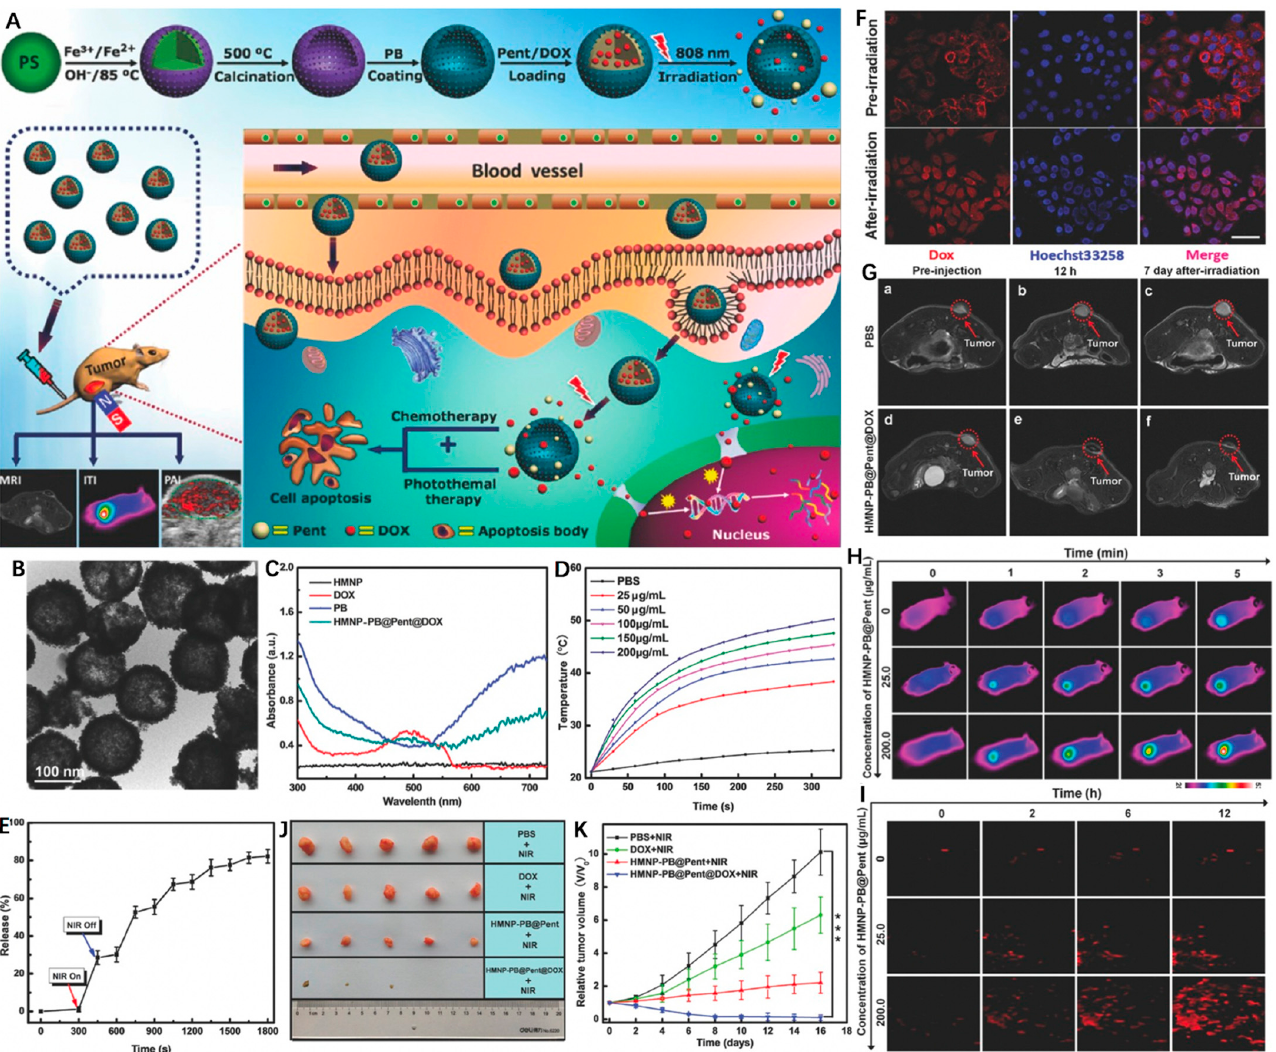
Figure 9. ( A ) Schematic illustration of the design and synthesis of HMNP-PB@Pent@DOX for NIR- guided synergetic chemo-photothermal tumor therapy with tri-modal imaging in vivo. ( B ) TEM image of HMNP-PB. ( C ) Representative UV–Vis–NIR absorption spectra of HMNP, DOX, PB, and